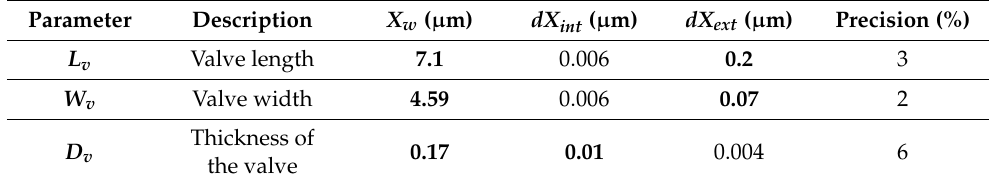
Figure 1. Light microscopy ( a ), SEM of the external valve view ( b ), FIB-SEM slice showing cross- sections of two individual cells ( c ), and 3D reconstruction of the frustule showing valves in red and girdle bands in white ( d ) of different Gomphonema parvulum cells. Some structural features are illustrated in ( b ), including: costae (i), striae (ii), a shortened stria (iii), punctate areola covered with a flab-like occlusion (iv), nodule zone (v), striae spacing max (vi)/min (vii), sternum (viii), raphe slit (ix), and the apical axis (x). Table 1. Statistical analysis of the structural parameters of GP valves (weighted mean, internal and external errors—the bold print indicates the significant error—and its precision in %). The weighted mean is used for building the 3D model (see Figure S1).